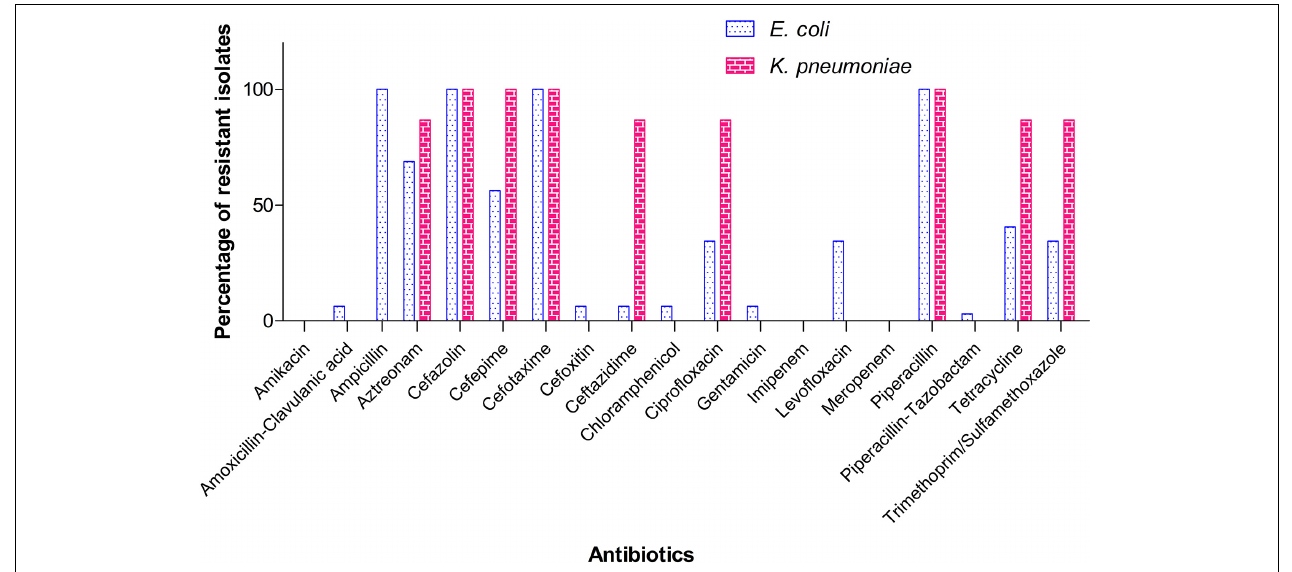
FIGURE 2 | Resistance pattern of the ESBL-producing E. coli and K. pneumoniae isolates toward different antibiotics. K. pneumoniae is intrinsically resistant to ampicillin and therefore not shown here.